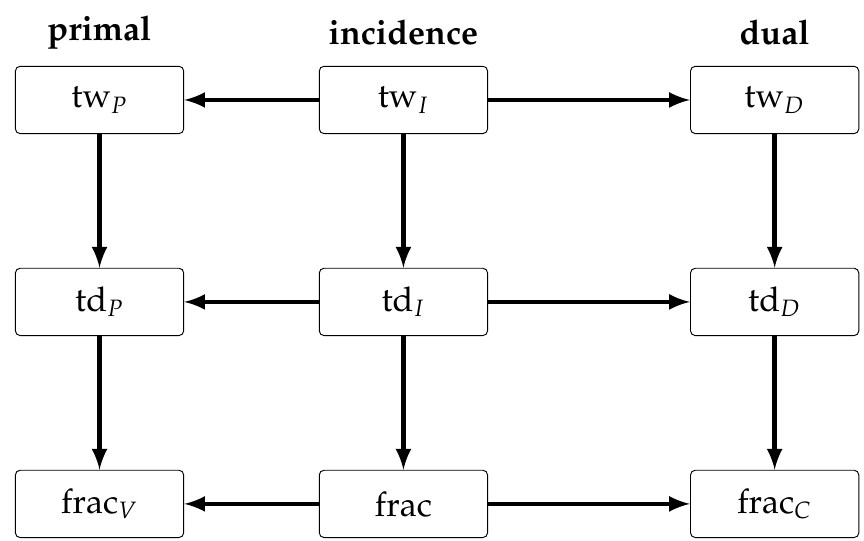
Figure 3. The relationship between the structural parameters treewidth, treedepth, and fracture number for the primal, dual, and incidence graph. An arc from one parameter to another indicates that the former is a more general parameter, i.e., whenever the later is bounded so is the former. The variable, constraint, and mixed fracture number are defined in Section